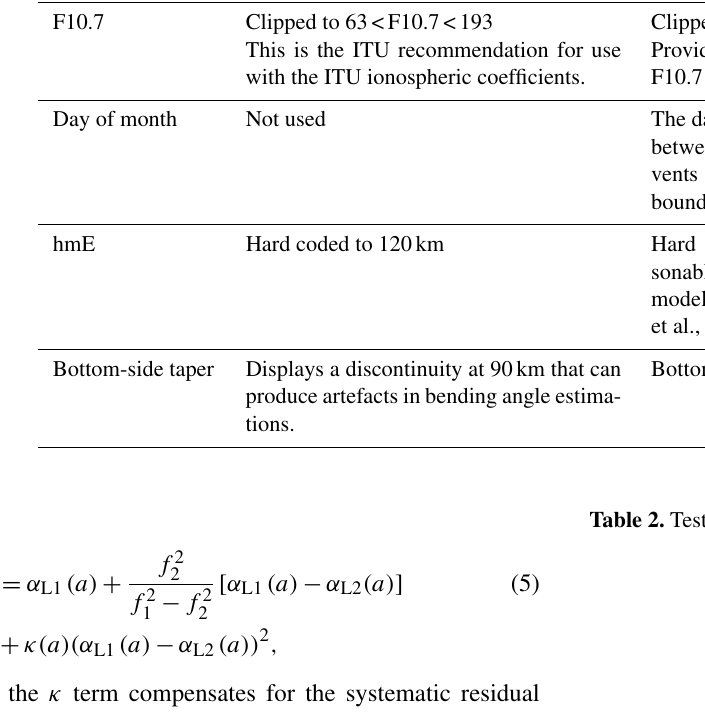
Table 1. Updates to produce the University of Birmingham (UoB) variant of NeQuick. Feature v2.0.2 UoB variant Clipped to 63<F10.7 F10.7 Clipped to 63<F10.7<193 with the ITU ionospheric coefficients.